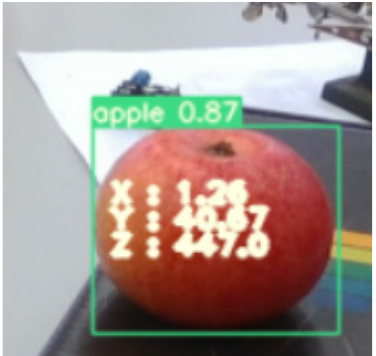
Table 3. Comparative analysis of red and green apple detection.